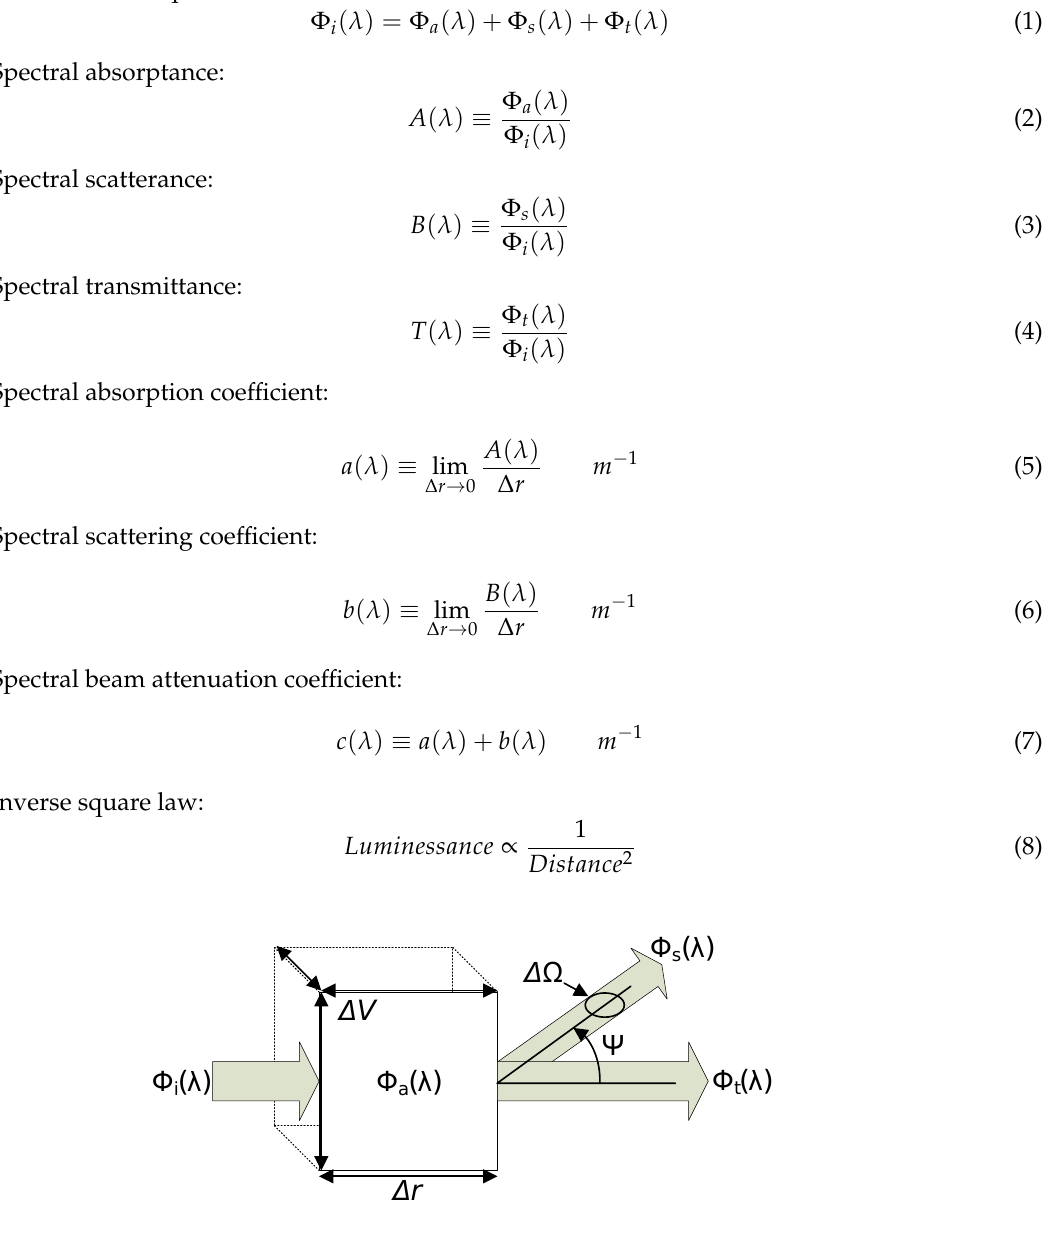
Figure 1. Model of optical